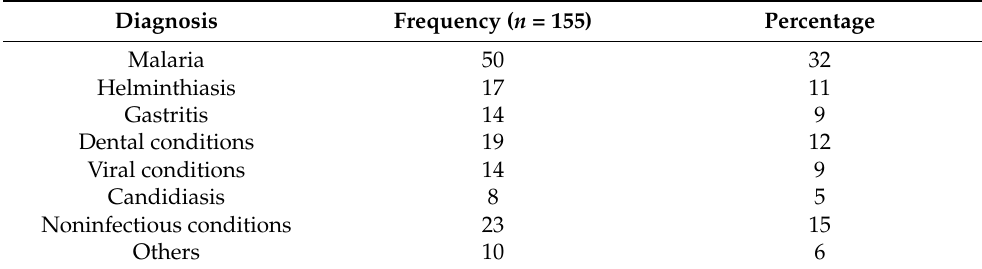
Table 4. Showing diagnosis for which antibiotic prescriptions were considered noncompliant